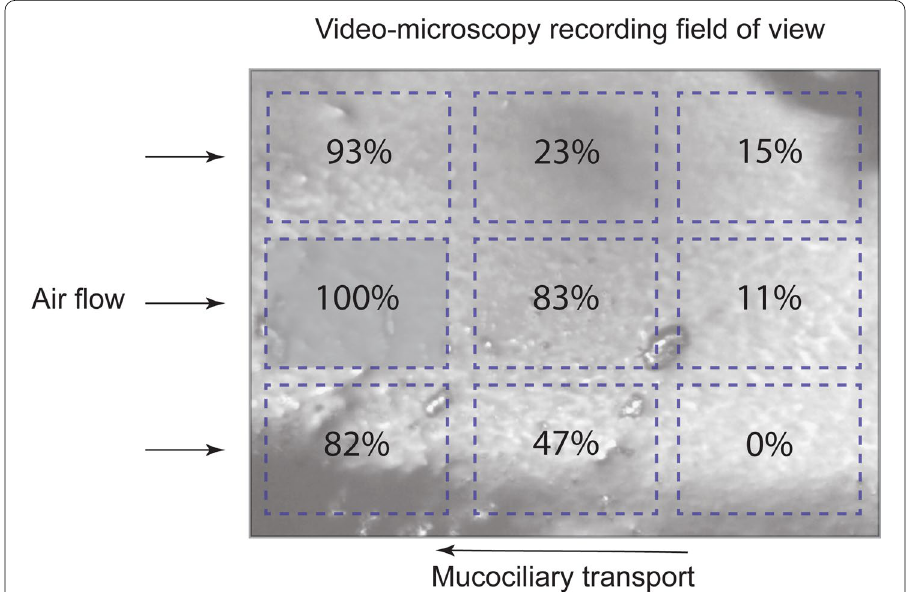
Fig. 6 The average percentage change in cilia beat frequency, from all video-microscopy recordings, made when the tracheal epithelium was exposed to room air (22 °C and 60% relative humidity) where 100% represents the largest percentage change